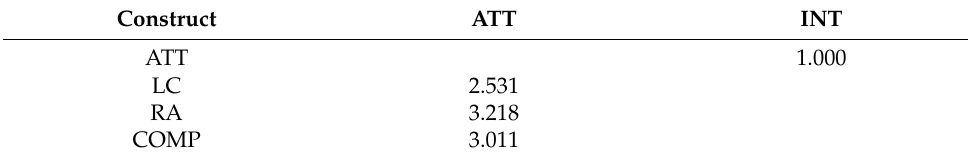
Table 13. Collinearity assessment (inner VIF).